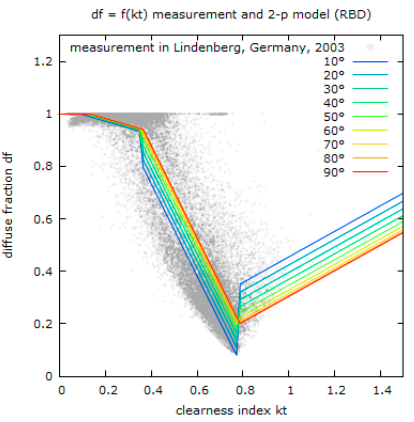
Figure 3. Measured diffuse fraction over clearness index kt for one year of measurement (grey points, extract of 2003) in Lindenberg, Germany. Line plots: The model by Reindl, Beckman and Duffie [3] (reduced version), using two parameters ( kt and sun height) as